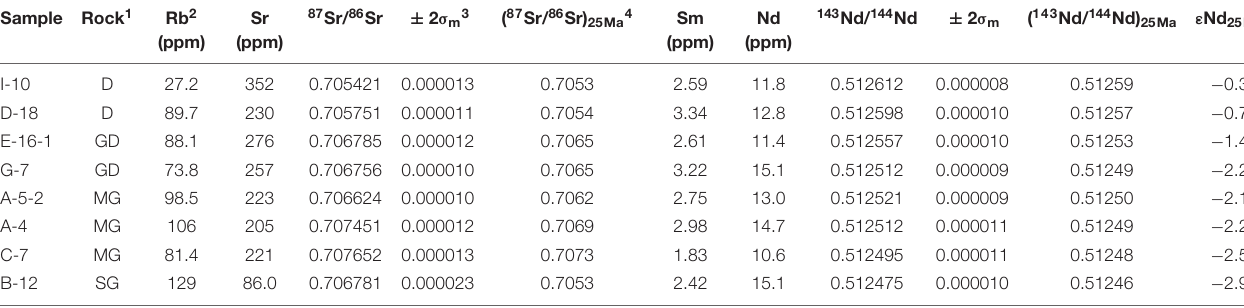
TABLE 2 | Sr-Nd isotopic data for a subset of the studied samples from the Takht batholith. Sample Rock 1